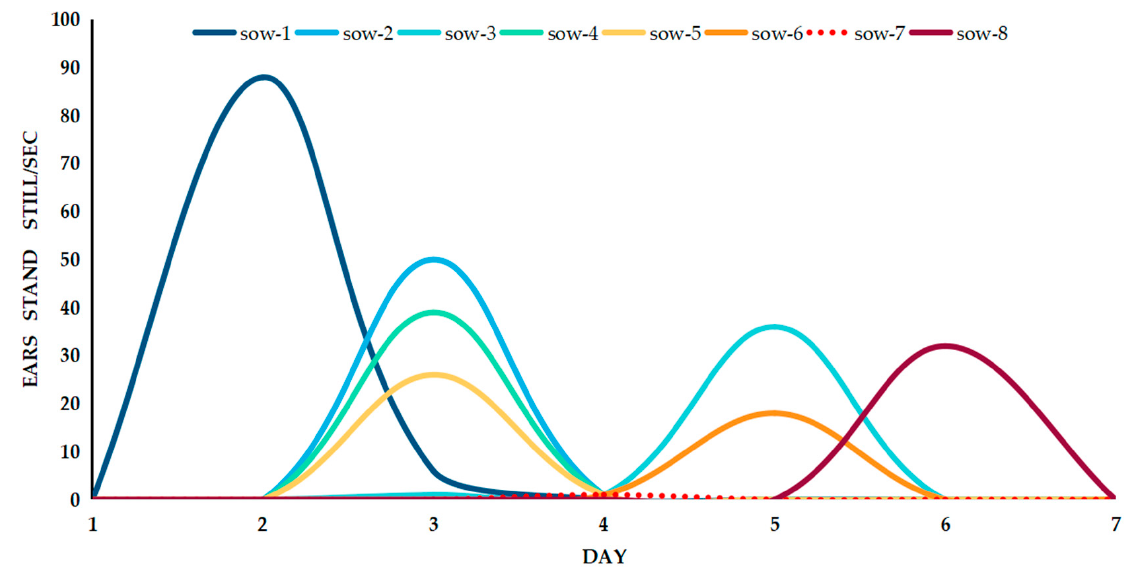
Figure 8. The time until a sow’s ears stand still 1–7 days after weaning (within three minutes for a single oestrus check). 3.3. Evaluation Rule of the Response of a Yorkshire Sow to a Bionic Boar from Weaning to Oestrus